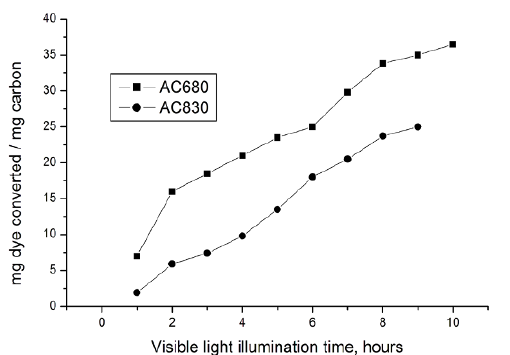
Figure 9. Comparison of the photocatalytic degradation activities of bare active carbon samples without any TiO prepared at 680 o C (AC-680) and at 830 o C (AC-830) under illumination with visible